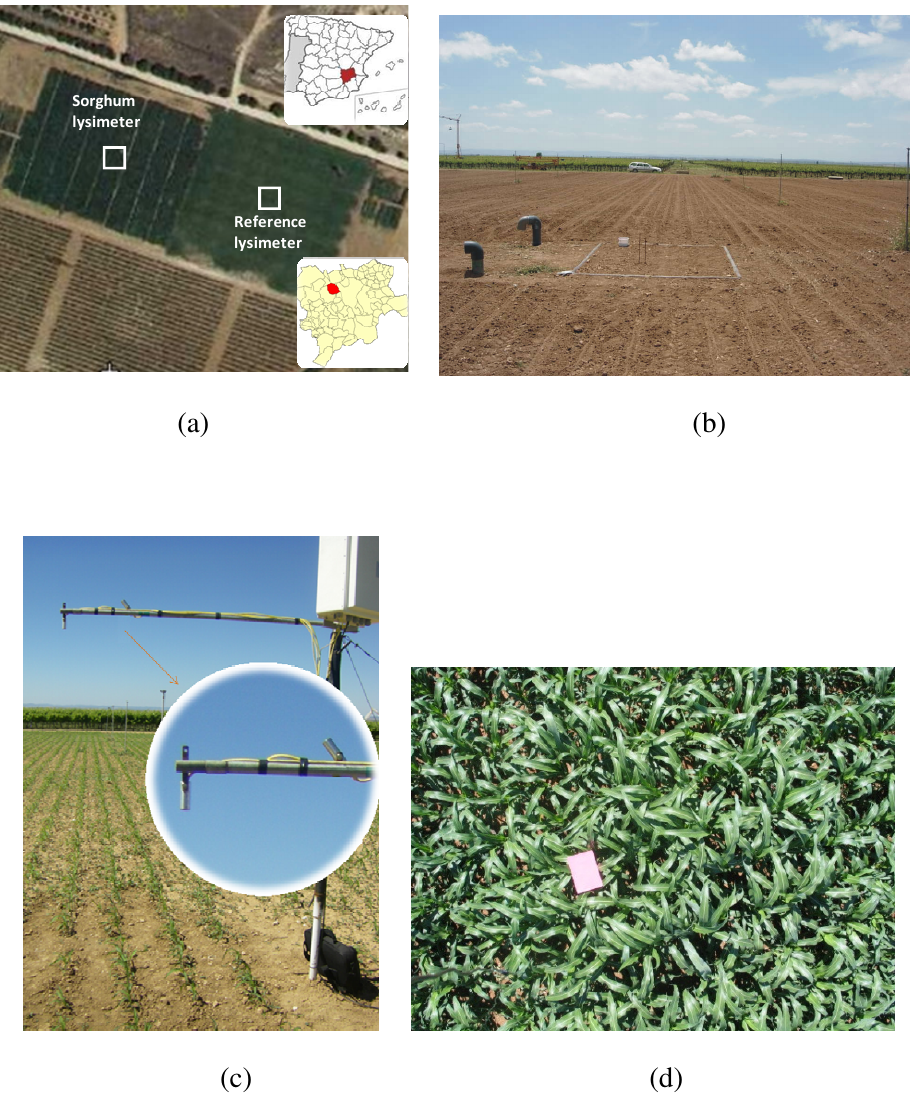
Fig. 1. (a) Location of the experimental site. (b) Lysimeter placed in the center of the sorghum field (picture from DOY 147). (c) Exper- imental assembly of the two Apogee IRTs over the incipient sorghum (picture from DOY 172). (d) Nadir view of the developed sorghum (picture from DOY